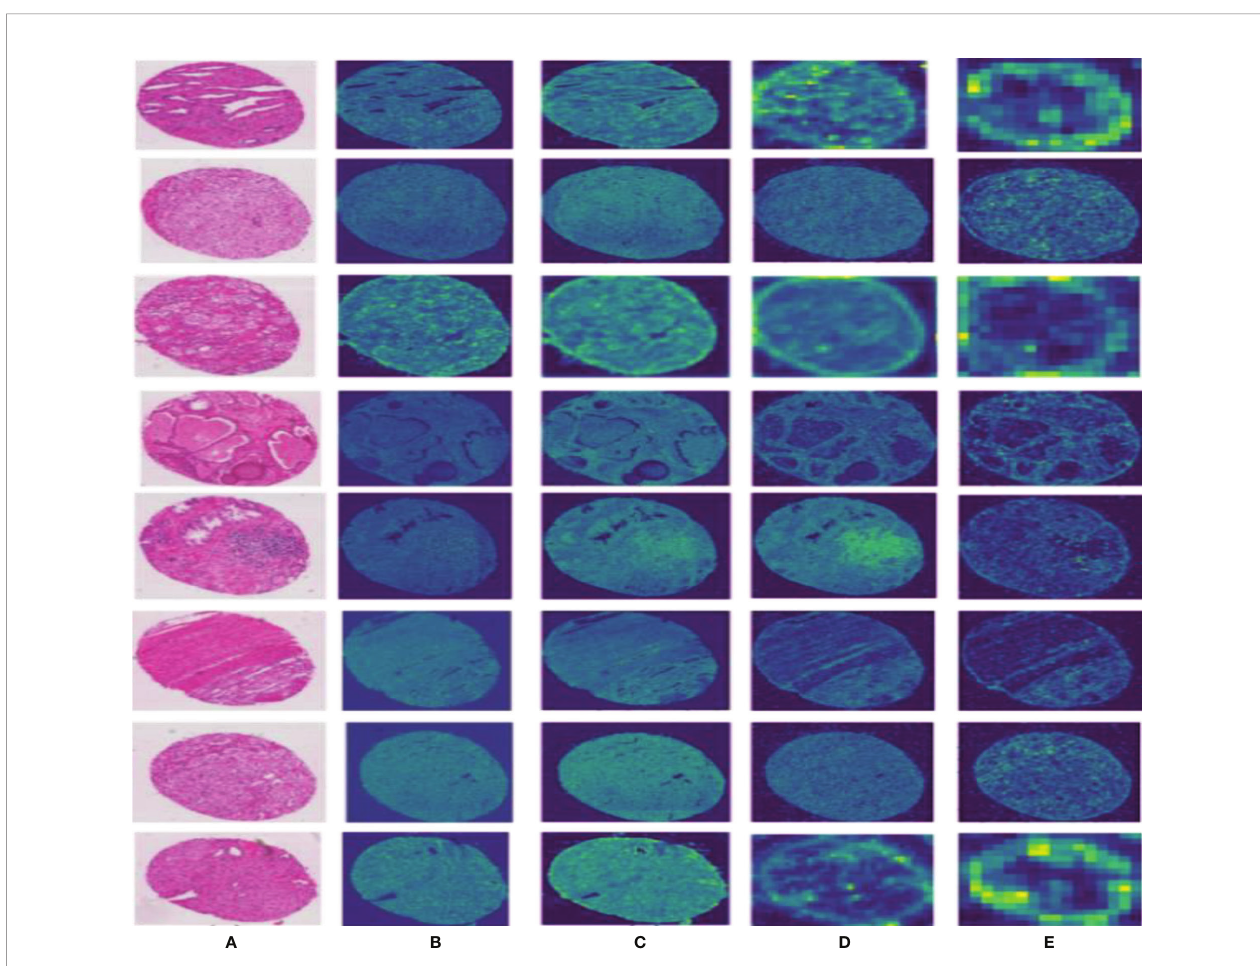
FIGURE 6 | Results of the feature map visualization. Column (A) is the input image; columns (B – E) show that feature maps are obtained via four convolutional layers in PPM,